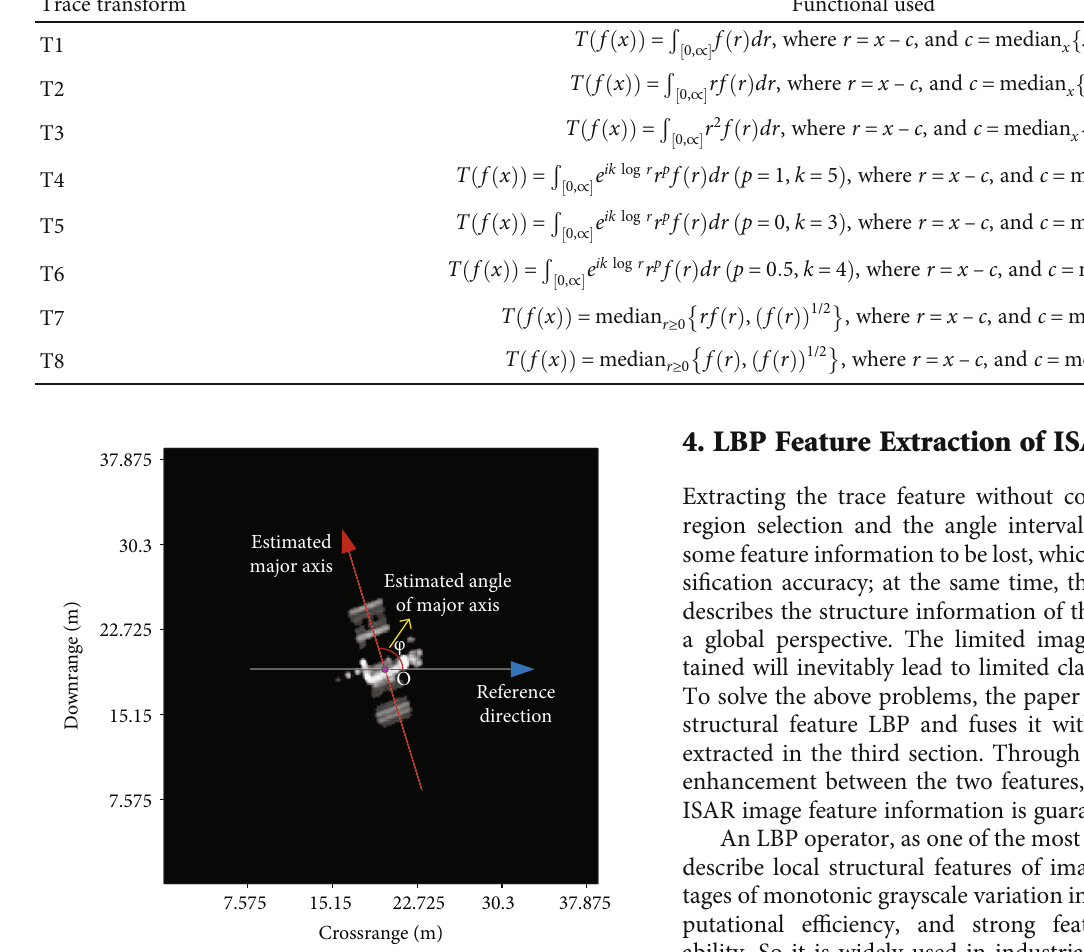
Figure 4: The longest axis of an ISAR